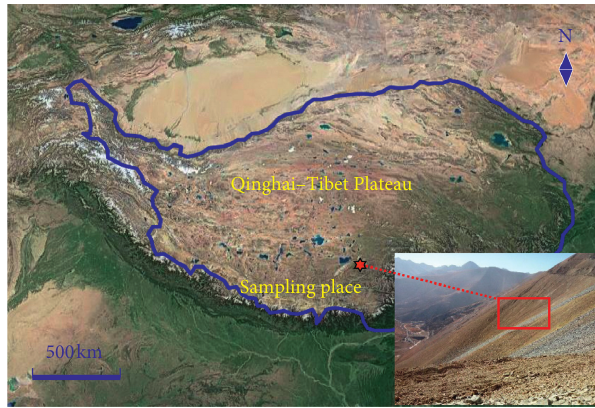
Figure 1: Sampling place in Qinghai-Tibet Plateau.